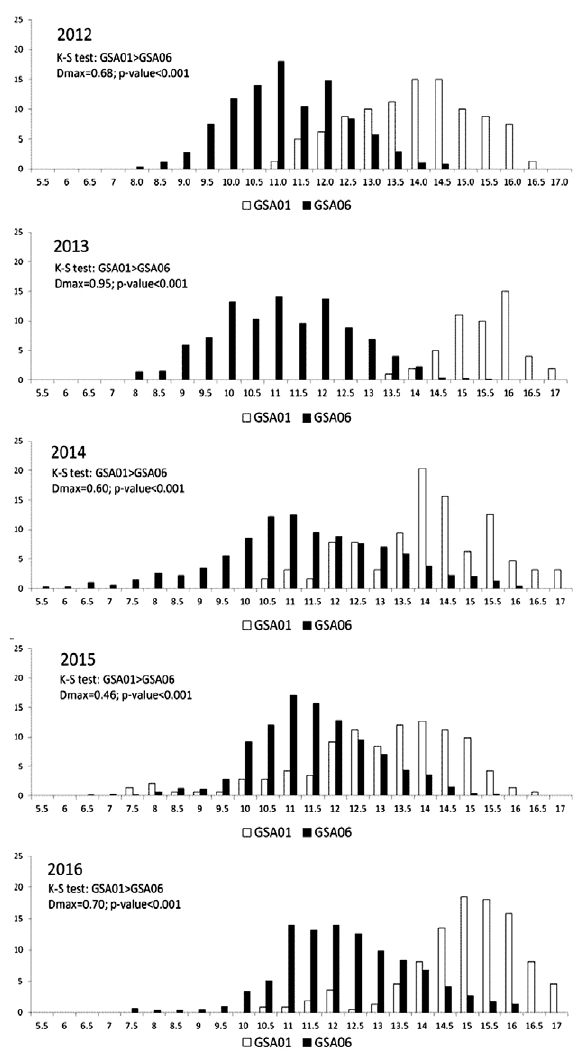
Fig. 3. – Anchovy length (to the nearest 0.5 cm) frequency distribu- tion in percentage of individuals for each GSA and year; in black GSA06 data and in white GSA01 data. The figure also shows the results of the Kolmogorov-Smirnov (K-S) test used to compare anchovy length distributions between GSAs: GSA01>GSA06 represent the null hypothesis “anchovies collected in GSA01 had a greater length than those collected in GSA06”, the maximum dif- ference between the two probability distributions (Dmax) and the